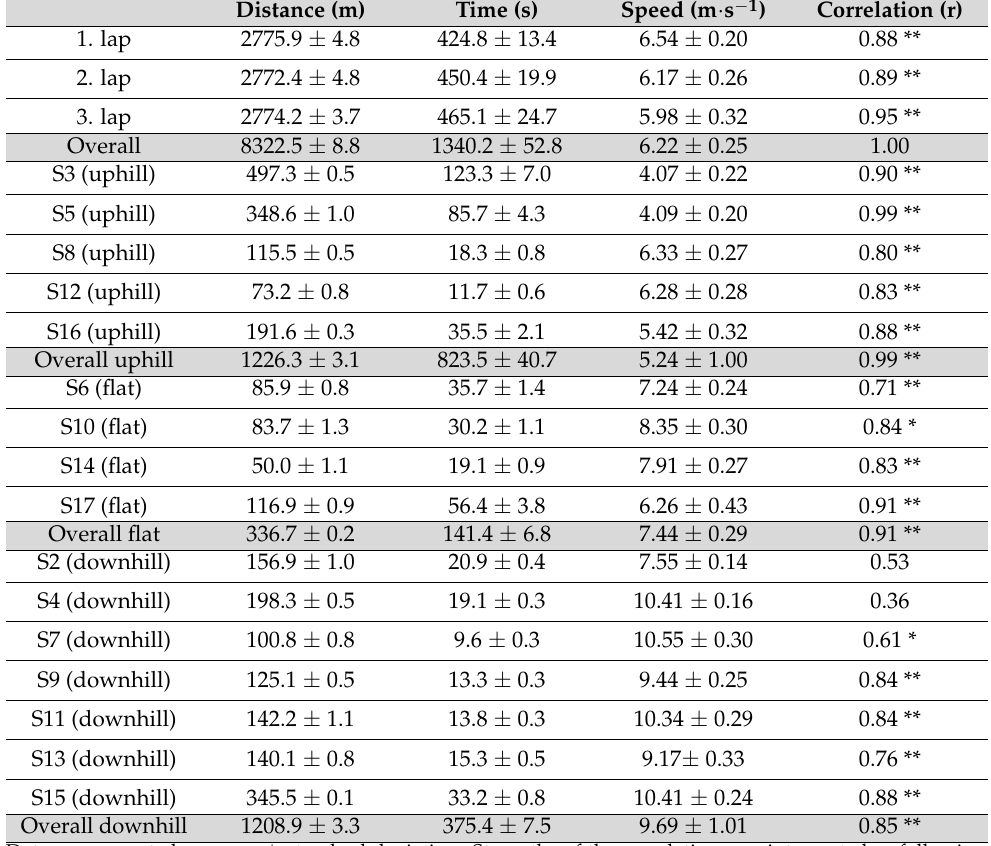
Table 2. Distance, time, and speed for overall distance, laps, and terrain sections, as well as correlations with overall time during a 10 km skating time-trial in fourteen national-level male cross-country